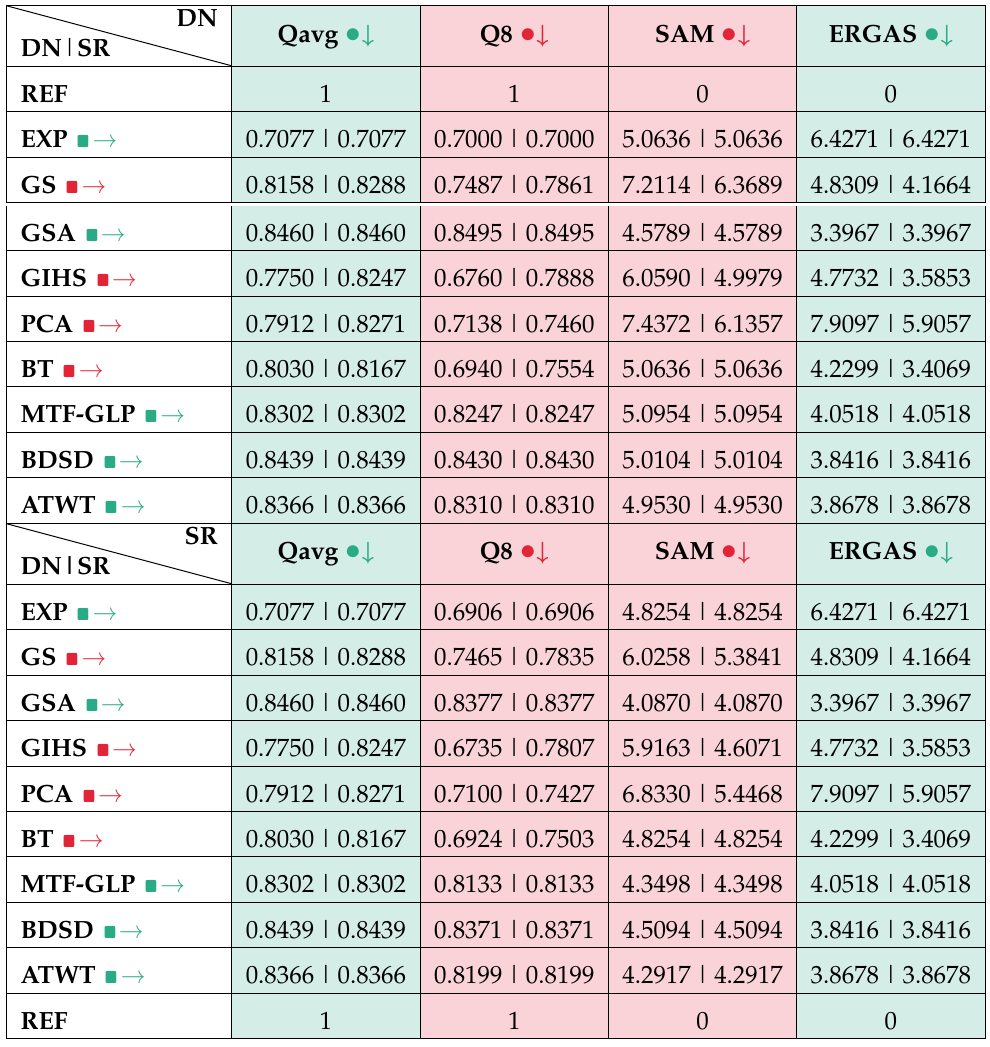
Table 6. Scores of WV-2 Sydney towards ground truth (REF) for nine fusion methods described in [39]. The upper subtable refers to assessments carried out on data in DN; the lower one in SR. Each entry of the table contains the values of a quality/distortion index relatively to fusion performed in either DN or SR. Reproducible indexes are highlighted in green; non-reproducible in red. Reproducible methods are marked by green squares; non-reproducible by red